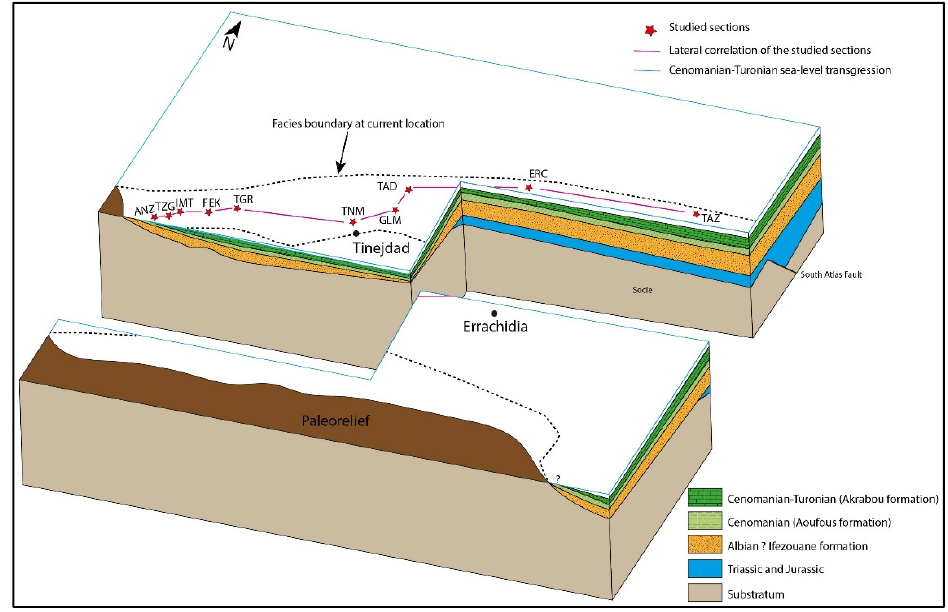
Figure 13. Synthetic block diagram showing the arrangement of the Cretaceous formations in